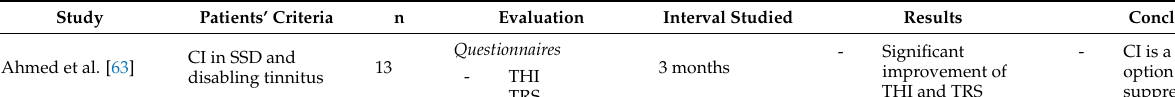
Table 3. Characteristics of studies investigating CI in SSD patients with disabling tinnitus in which tinnitus was the primary